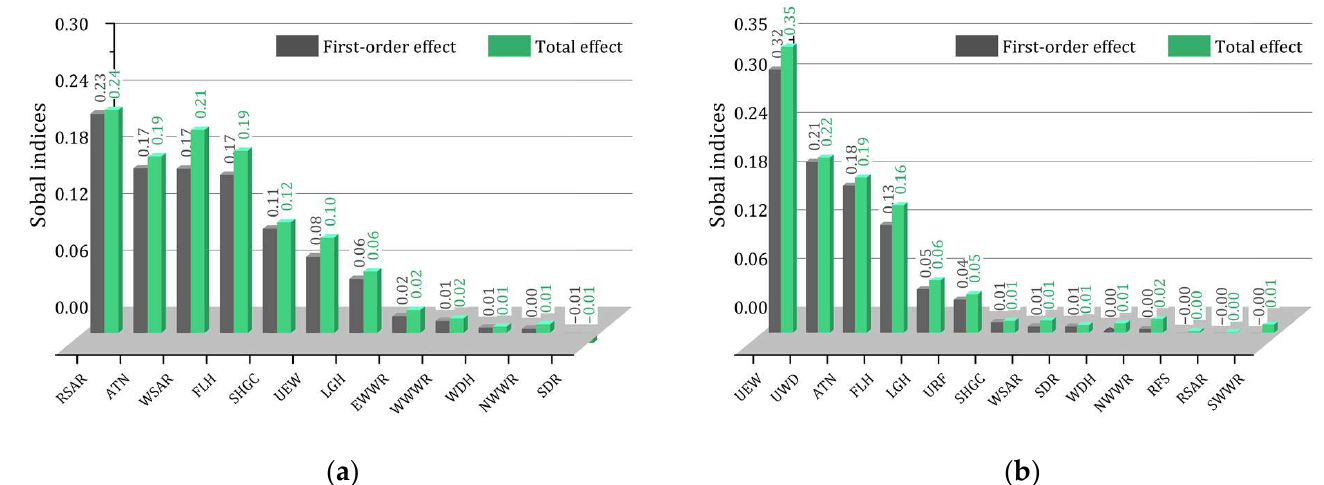
Figure 9. First-order effect indices ( S 1 ) and total effect indices ( S t ) of sensitivity parameters to energy demand obtained by the Sobol method in the second-stage SA: ( a ) cooling demand; ( b ) heating de- mand.